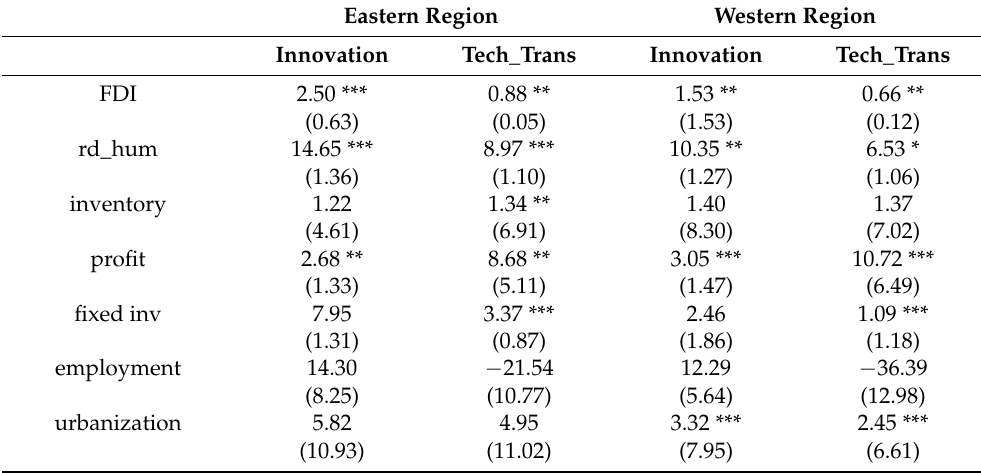
Table 7. Heterogeneity analysis on the moderating effect of environmental regulation. Eastern